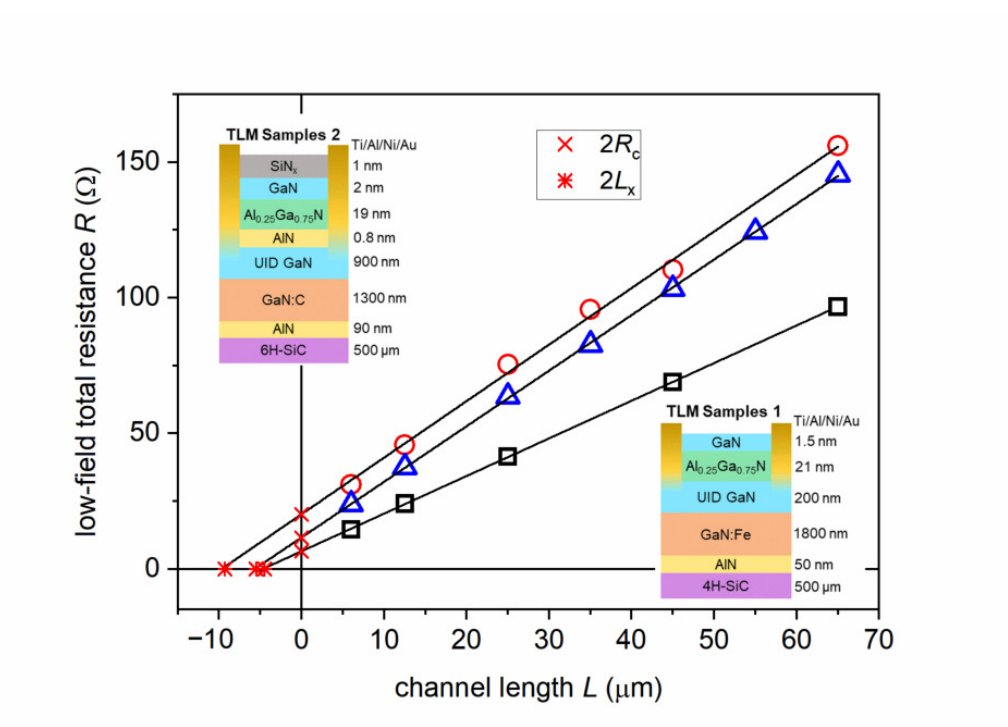
Figure 2. The dependence of the low-field total resistance R on the channel length L . Data for group of TLM samples 1, fabricated of AlGaN/GaN (bottom inset), are shown by rectangles, meanwhile, the triangles as well as circles demonstrate results for other two groups of TLM samples 2, made of AlGaN/AlN/GaN (top